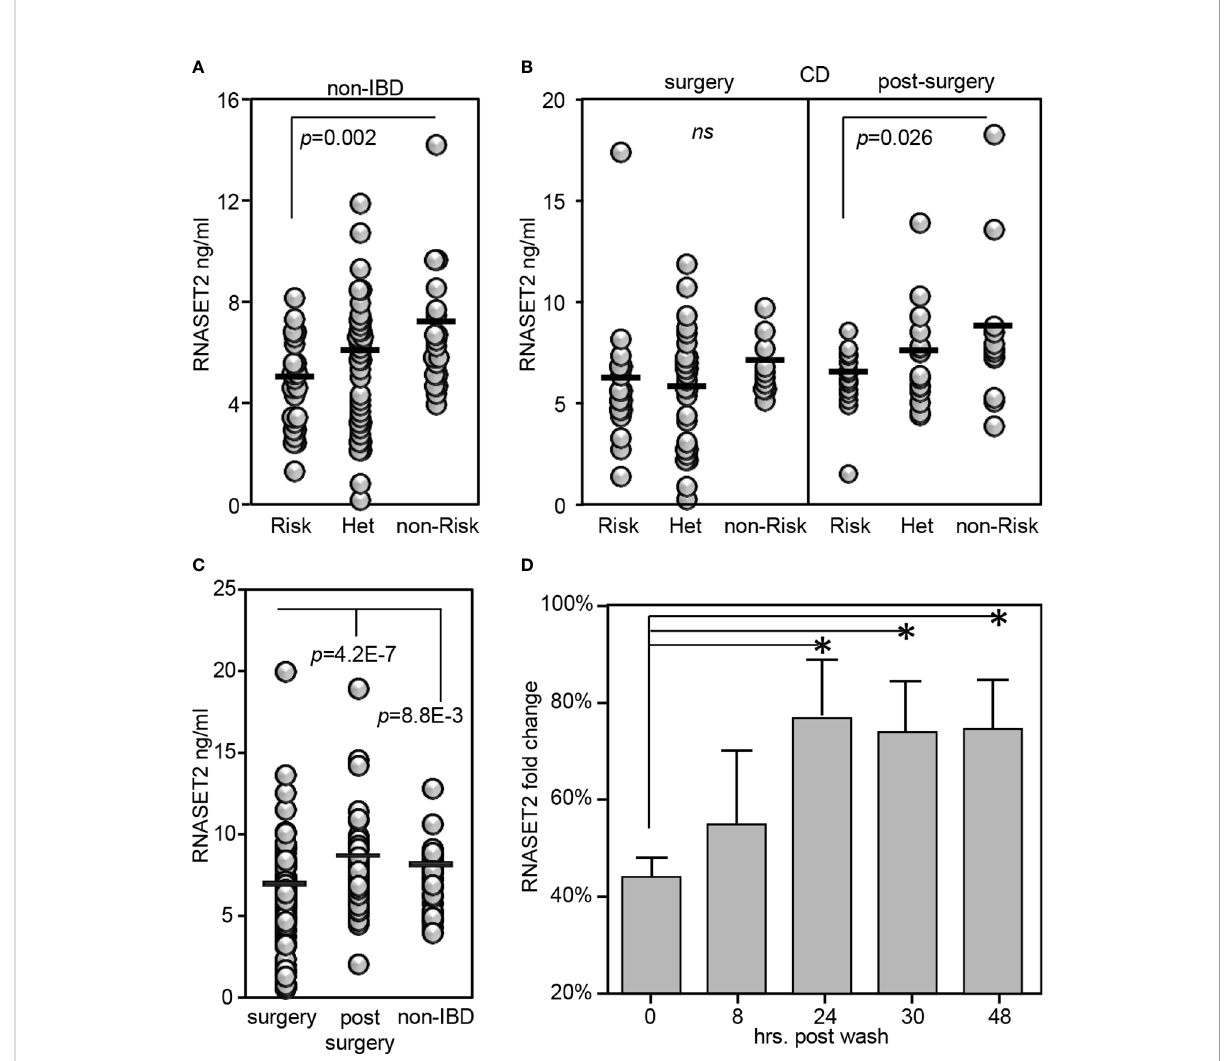
FIGURE 7 RNASET2 risk variant is associated with decreased levels of circulating protein. Circulating RNASET2 protein levels associated with allelic carriage in (A) non-IBD subjects ( n =84) or (B) CD patients at time of surgery ( n =93 left panel) and up to one year post surgery ( n =47 right panel). (C) Increase in circulating levels of RNASET2 following surgical removal of in fl amed intestinal region. (D) Recovery of RNASET2 transcript levels in CD4 + T cells following removal of TL1A activation ( n =6). Data show the mean ± SD. * P <